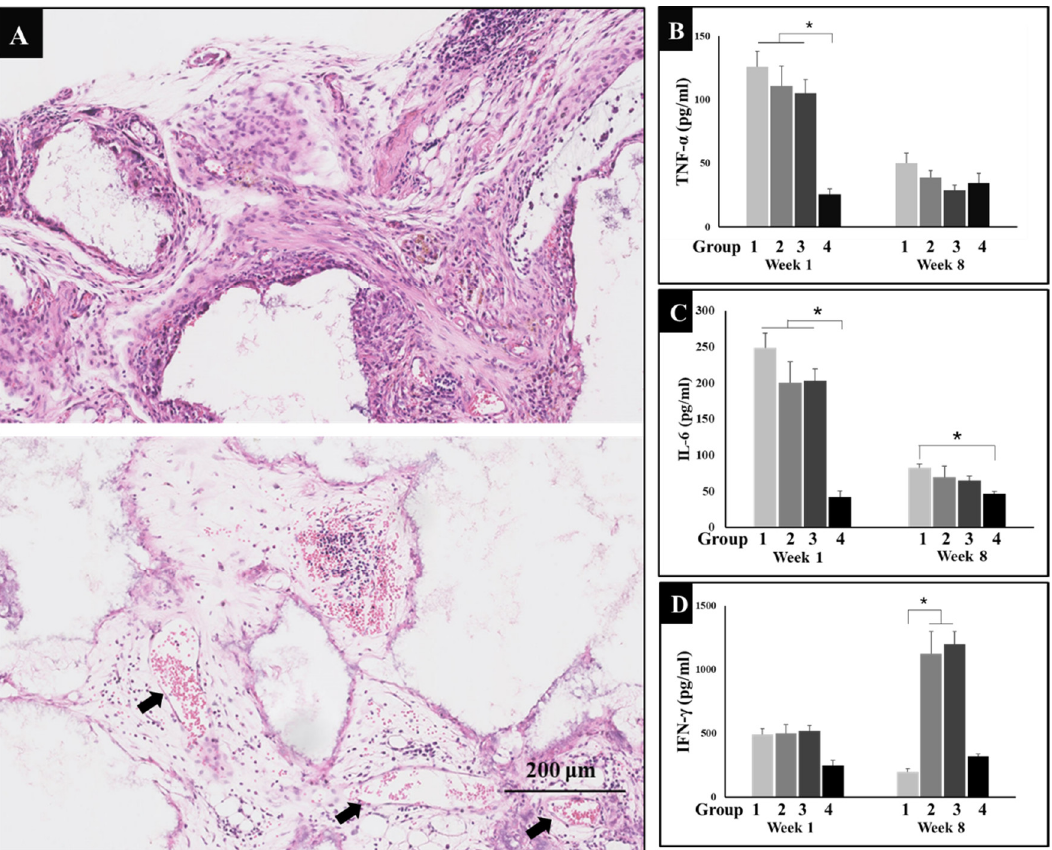
Figure 2. ( A ) Hematoxylin and eosin (HE) micrograph of group 3 ( n = 6) showed inflammatory reactions and new blood vessels one week after surgery, arrow: blood vessel; bar: 200 μm. ( B ) The levels of tumor necrosis factor-α (TNF-α) secreted in serum of four groups ( n = 5) at weeks 1 and 8; comparison among group 4 and other the three groups at week 1, * P < 0.05. ( C ) The levels of interleukin-6 (IL-6) secreted in serum of four groups ( n = 5) at weeks 1 and 8; comparison among group 4 and other three groups at week 1, comparison between group 1 and group 4 at week 8, * P < 0.05. ( D ) The levels of interferon-γ (IFN-γ) secreted in serum of four groups ( n = 5) at weeks 1 and 8; comparison among group 1 and groups 2, 3 at week 8, * P < 0.05. Group 1 = negative control group; Group 2 = running group; Group 3 = weight-bearing group; Group 4 = positive control group.